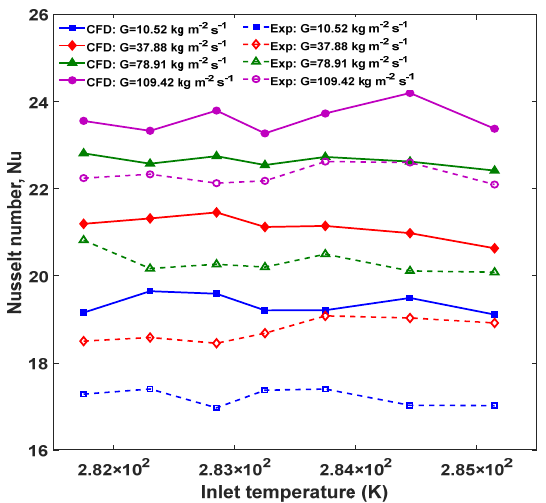
Figure 12. Contrast of the experimental Nusselt number (Nu) and numerical Nu versus the inlet temperature for different mass flux values and p = 0.65 MPa.